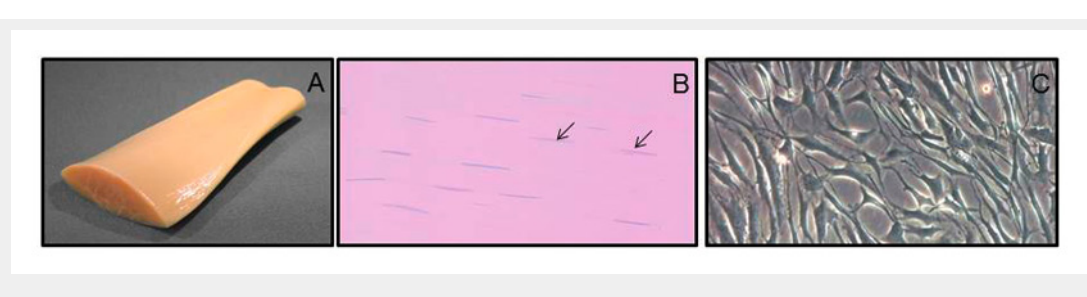
Tendon structure, histology and cell culture. Ultrastructure of tendon showing longitudinal fibres and histological sections stained with haematoxylin and eosin depicting extracellular matrix colored in pink (~80% composition) and cellular components mainly with tenocytes stained in blue (~20% composition)(horse tendon for illustration). Primary cultures from tissue can be developed by culturing cells in minimal medium (DMEM + 10% FBS + 1% glutamine) for